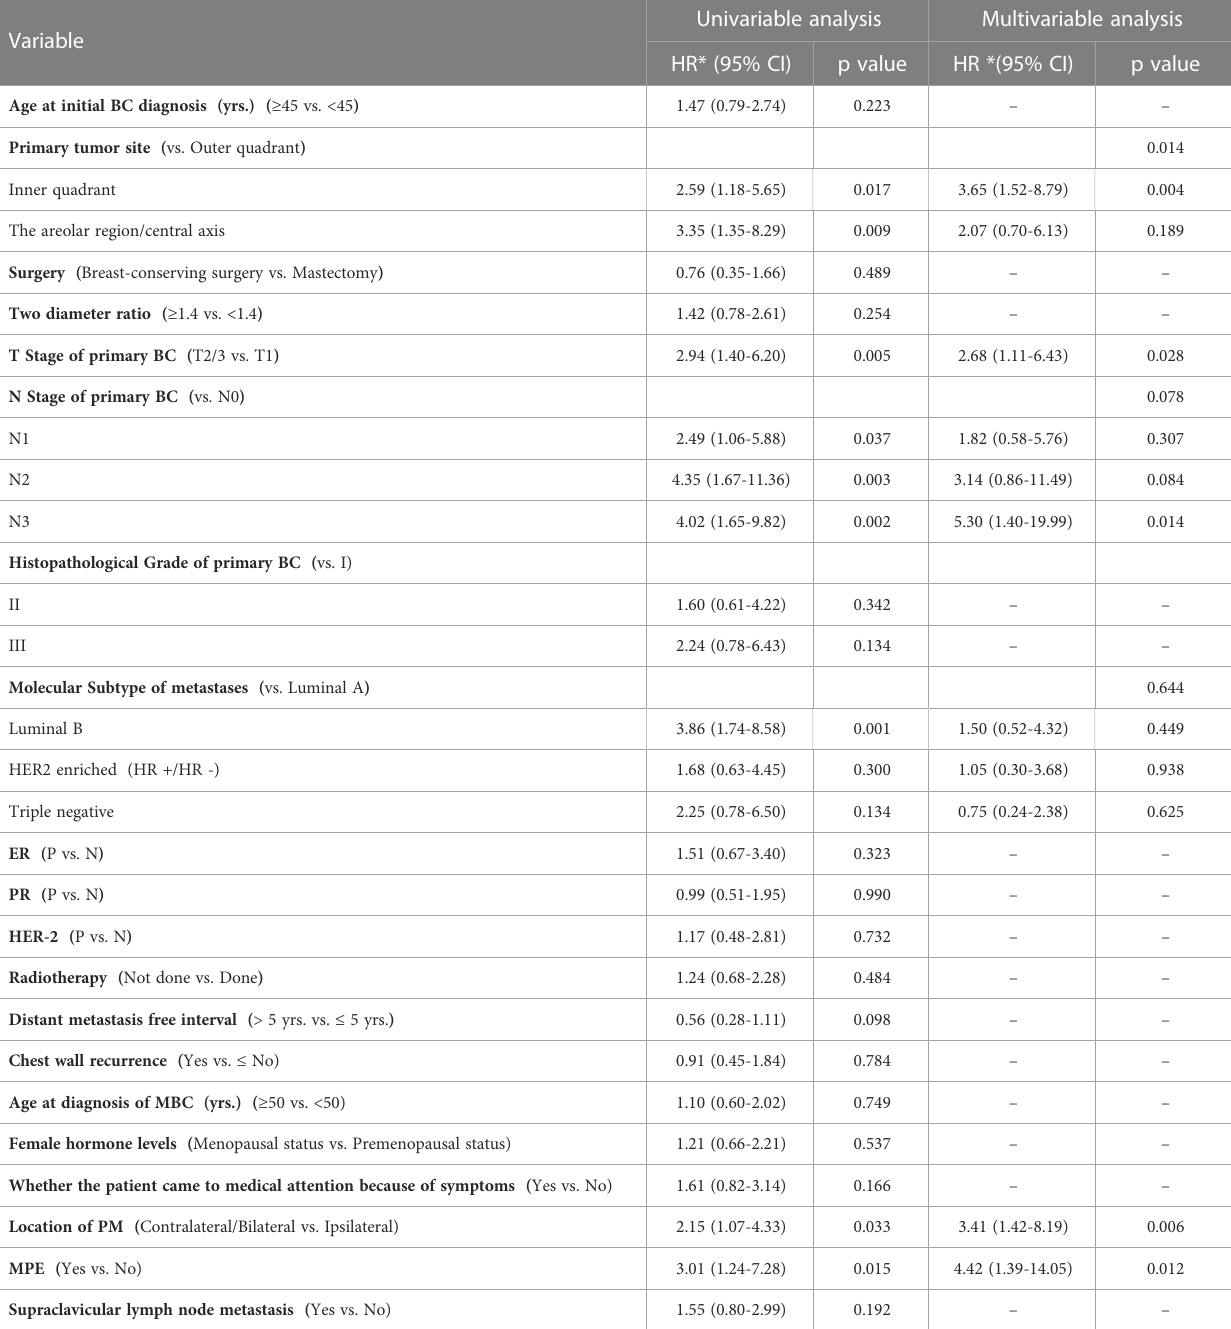
TABLE 3 Cox analysis of prognostic factors in patients with PM as the only site of distant metastasis at fi rst diagnosis of